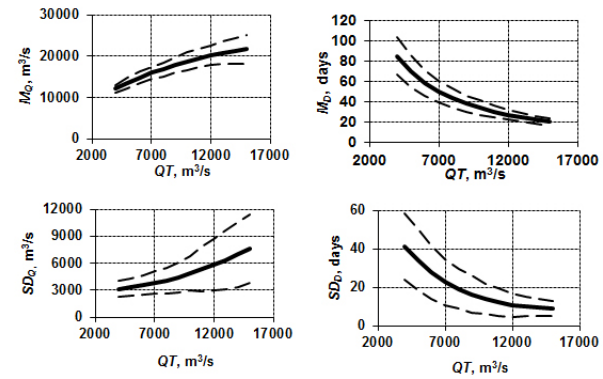
Figure 5. Estimates of high-flow statistics (solid lines) and bounds of their 99%-confidence interval (dashed lines) in dependence on the threshold daily discharge value